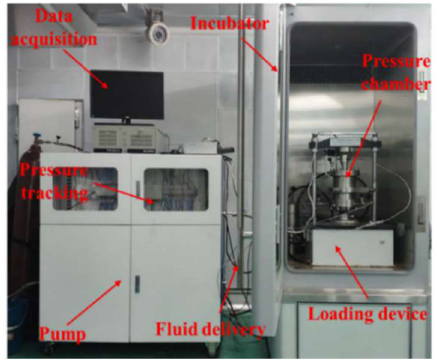
Figure 1. Schematic diagram of the triaxial test